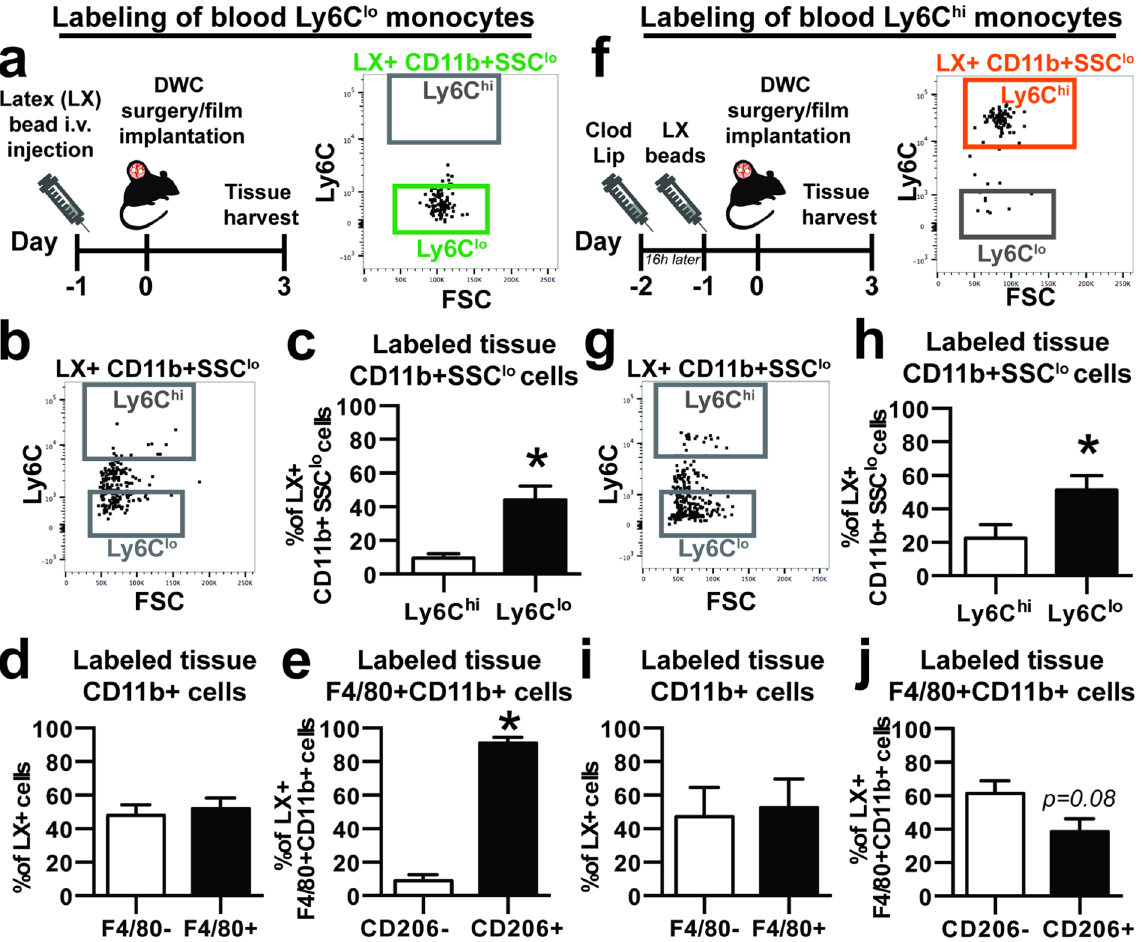
Figure 2. Circulating non-classical Ly6C lo monocytes selectively give rise to CD206 + wound repair macrophages. ( a ) Latex (LX) beads were injected 1 day prior to DWC surgery to selectively label blood Ly6C lo monocytes. Right, flow cytometry dot plot of labeled blood LX + CD11b + SSC lo cells shows selective Ly6C lo monocyte labeling 1 day post-injury. ( b,c ) Labeled monocytes collected from digested dorsal tissue 3 days post-injury. ( d ) Frequency of bead-labeled F4/80 + cells in animals with labeled blood Ly6C lo monocytes. ( e ) Frequency of bead-labeled CD206 + cells out of total F4/80 + CD11b + cells. ( f ) Blood Ly6C hi monocytes were selectively labeled by first depleting blood monocytes with i.v. clodronate liposome (Clod Lip) administration 2 days prior to injury, followed by LX bead-based labeling 16 h later. Right, flow cytometry dot plot of labeled blood LX + CD11b + SSC lo cells shows selective Ly6C hi monocyte labeling 1 day post-injury. ( g , h ) Labeled monocytes collected from digested dorsal tissue 3 days post-injury. ( i ) Frequency of bead-labeled F4/80 + cells in animals with labeled blood Ly6C hi monocytes. ( j ) Frequency of bead-labeled CD206 + cells out of total F4/80 + CD11b + cells. Data presented as mean ± S.E.M. Statistical analyses performed using two-tailed t-tests. * p < 0.05, n = 4–11 animals per